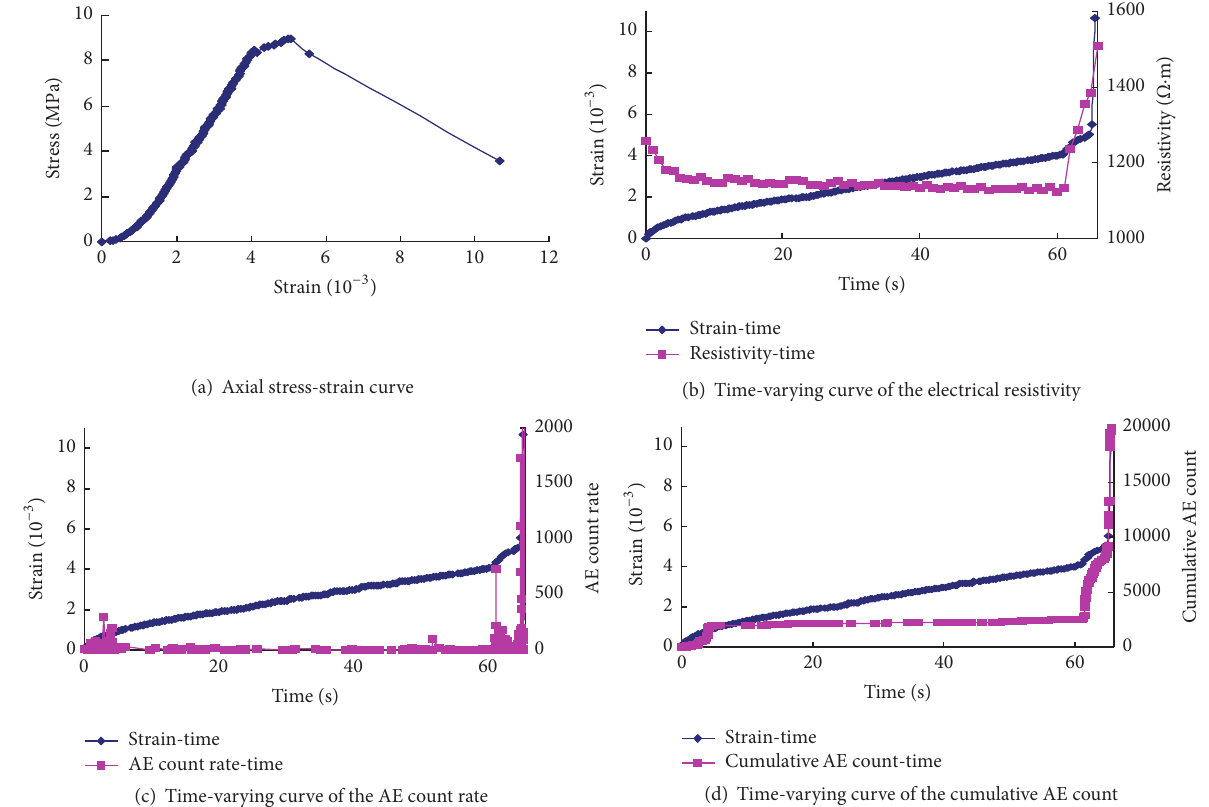
Figure 4: Test results of samples whose loading directions are vertical to the bedding